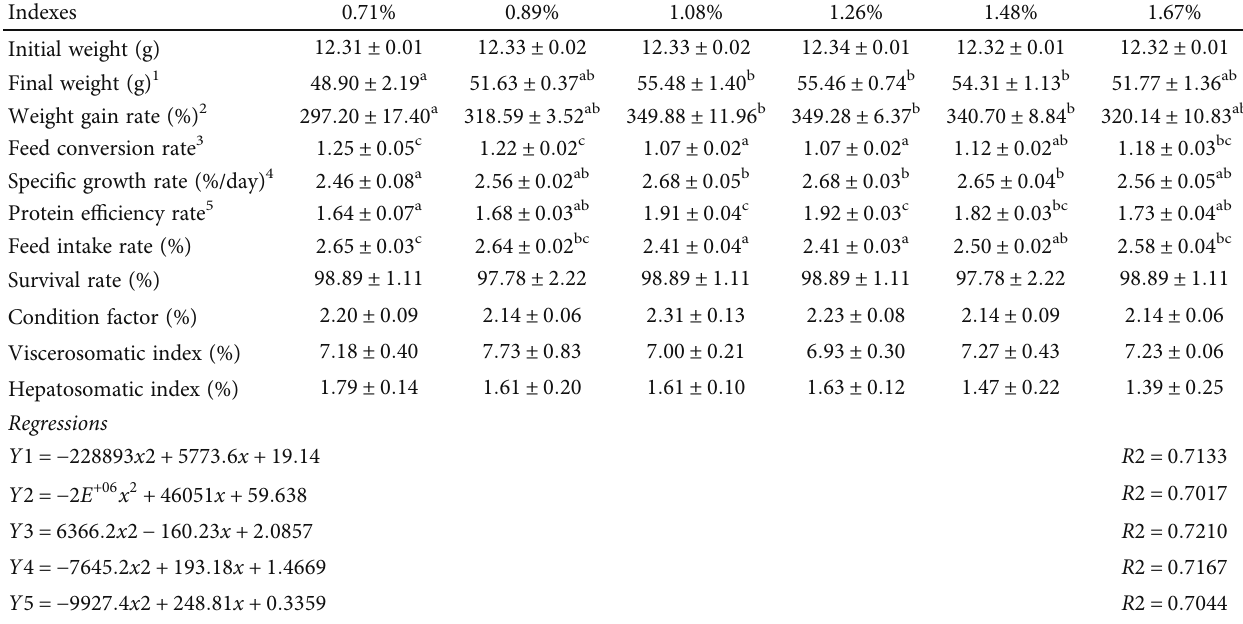
Table 5: Growth performance of juvenile largemouth bass fed with the experimental diets.